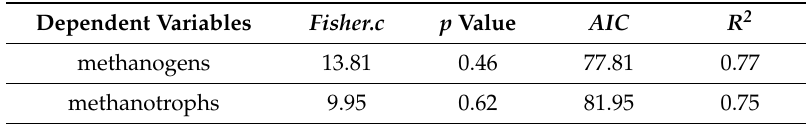
Figure 6. Structural equation model (SEM) of the relationship between the abundance (qPCR) of methanogens ( A ) and methanotrophs ( B ) and environmental factors in the three sites. Solid red arrows represent positive paths ( p < 0.05, piecewise s.e.m.), solid blue arrows represent negative path ( p < 0.05, piecewise s.e.m.) and dotted blue arrows represent non-significant paths ( p > 0.05, piecewise s.e.m.). Table 3. Statistics of the structural equation model (SEM) of the relationship between the abundance of methanogens and methanotrophs and environmental factors in the three sites.